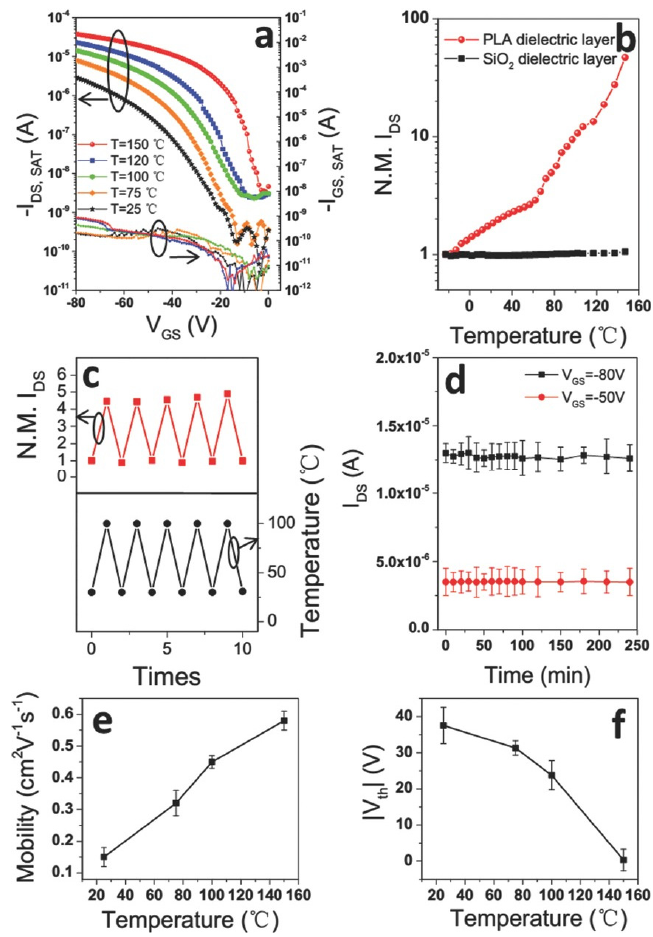
Figure 6. Temperature sensitivity of DNTT-tascPLA-OFETs: ( a ) transfer characteristics of DNTT- tascPLA-OFET ( V DS = -60 V) at different temperatures, ( b ) normalized (N.M.) I DS at different temper- atures of the OFETs with tascPLA or SiO 2 dielectric layers, ( c ) normalized I DS of the DNTT-tascPLA- OFET measured between two temperatures of 25 and 100 °C, ( d ) I DS of the tascPLA–OFETs main- tained at 100 °C as a function of time at V DS = -80 V at two different V GS , and ( e ) μ and ( f ) V T of the DNTT-tascPLA-OFETs at different temperatures. Reproduced with permission from [40] Wiley- VCH, 2015.